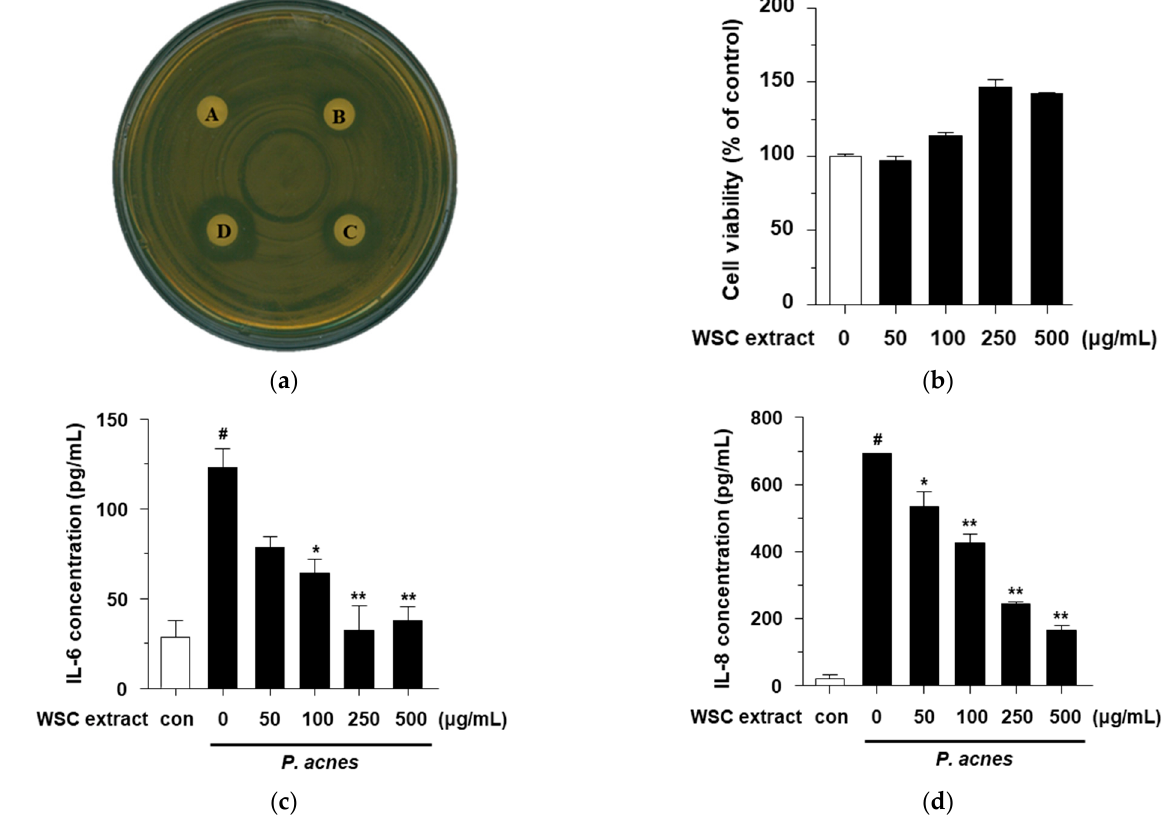
Figure 6. Antibacterial and anti-inflammatory effects of the WSC extract: ( a ) Antibacterial effects of the WSC extract measured by agar disk diffusion assay ( A , DMSO; B , 1 mg/disk of WSC extract; C , 2 mg/disk of WSC extract; D , 3 mg/disc of WSC extract); ( b ) Cytotoxicity of the WSC extract was measured in HaCaT cells by dimethylthiazol-diphenyltetrazolium bromide assay; ( c , d ) Secretion levels of IL-6 and IL-8 were determined using an ELISA kit. Values are expressed as the mean ± standard deviation of three independent experiments; #, p < 0.05 versus control; *, p < 0.05; **, p < 0.005 versus LPS alone.